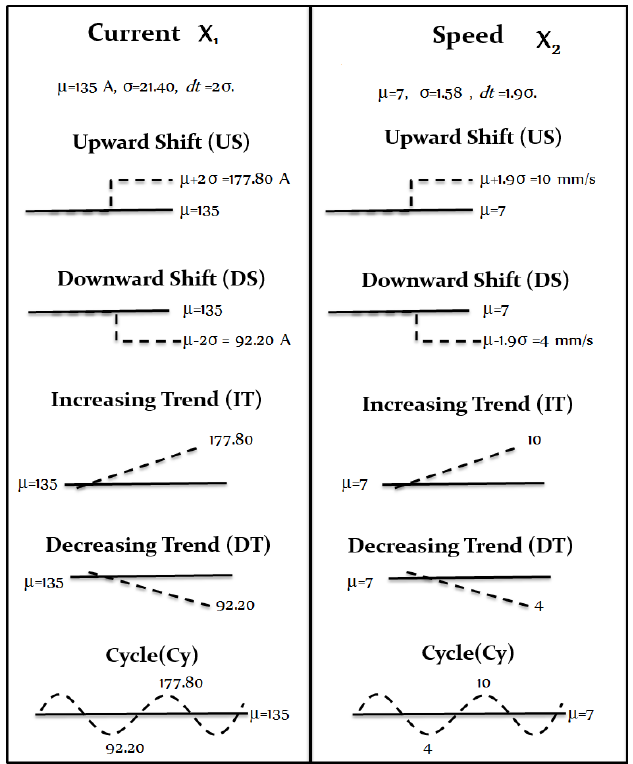
Figure 2. Parameters to generate special patterns.